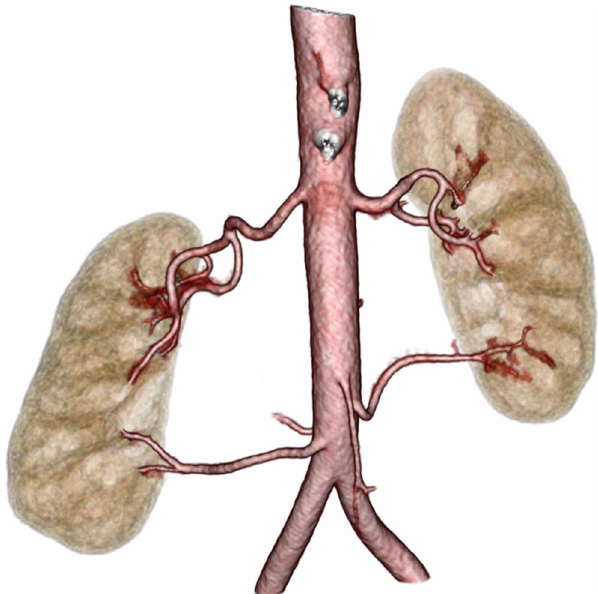
Fig. 12 Three dimensional segmented volume rendered image of the kidneys and their arterial supply in a renal donor volunteer, segmented from an arterial phase renal artery angiogram CT, demonstrates bilateral accessory renal arteries supplying the lower renal